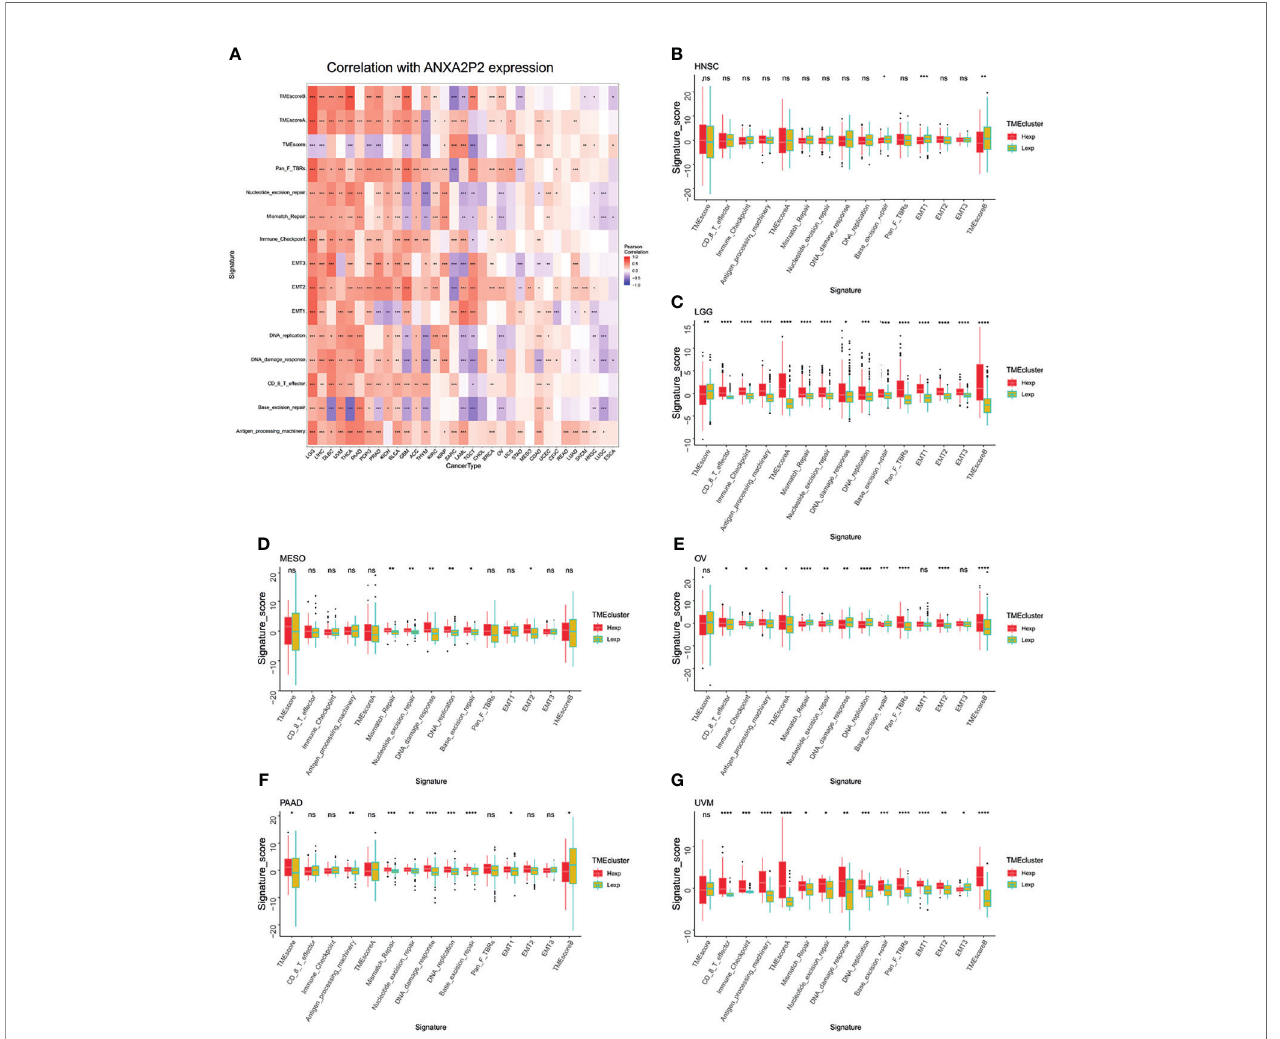
FIGURE 4 | Analysis of tumor microenvironment associated with ANXA2P2. (A) Associations between tumor microenvironment and ANXA2P2 in pan-carcinoma. The relationships of tumor microenvironment and different ANXA2P2 expression subtypes in (B) HNSC, (C) LGG, (D) MESO, (E) OV, (F) PAAD, and (G) UVM; the red means the high-expression subtype, and the yellow-green indicates the low-expression subtype. *P < 0.05, **P < 0,01, ***P < 0.001, ****P < 0.0001 and ns indicated no signi fi